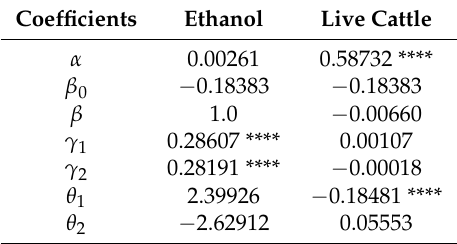
Table 6. The VECM for the ETH-LCA pair in P 3 . Significance levels: 10% (*), 5% (**), 1% (***) and 0.1%